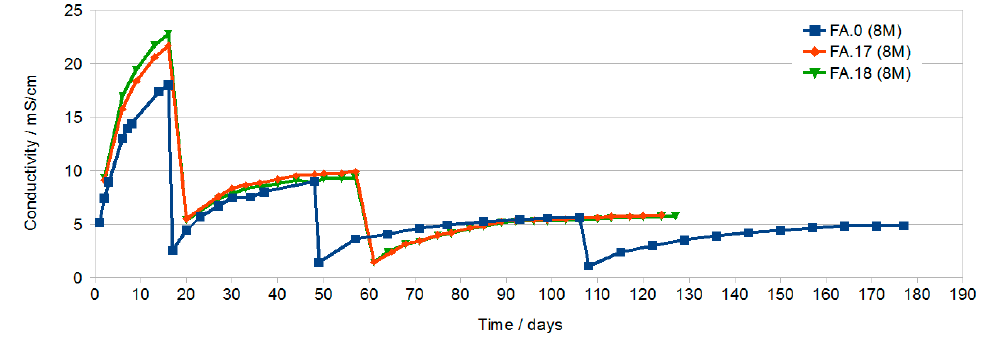
Figure 6. Conductivity of samples FA.0 (8 M), FA.17 (2% TiO 2 ), and FA.18 (4% TiO 2 ) as a function of Figure 6 . Conductivity of samples FA.0 (8 M), FA.17 (2% TiO 2 ), and FA.18 (4% TiO 2 ) as a function of Figure 6 . Conductivity of samples FA.0 (8 M), FA.17 (2% TiO 2 ), and FA.18 (4% TiO 2 ) as a function of Figure 6 . Conductivity of samples FA.0 (8 M), FA.17 (2% TiO 2 ), and FA.18 (4% TiO 2 ) as a function of immersion time with periodic water changes. immersion time with periodic water changes. immersion time with periodic water changes. immersion time with periodic water changes.